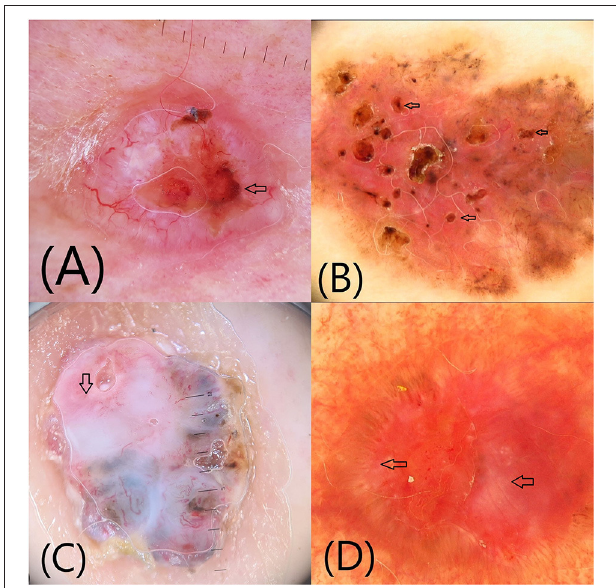
FIGURE 2 | Additional dermoscopic structures (arrows): (A) Ulceration (B) Multiple small erosions (C) Shiny white-red structureless areas (D) Shiny white